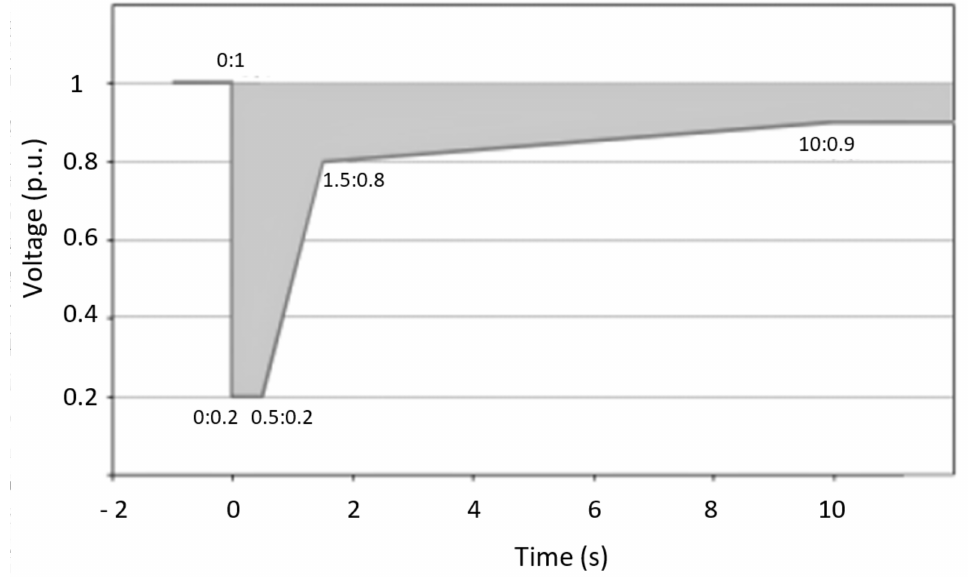
Figure 1. Fault ride-through requirement for wind turbines in the Portuguese transmission grid